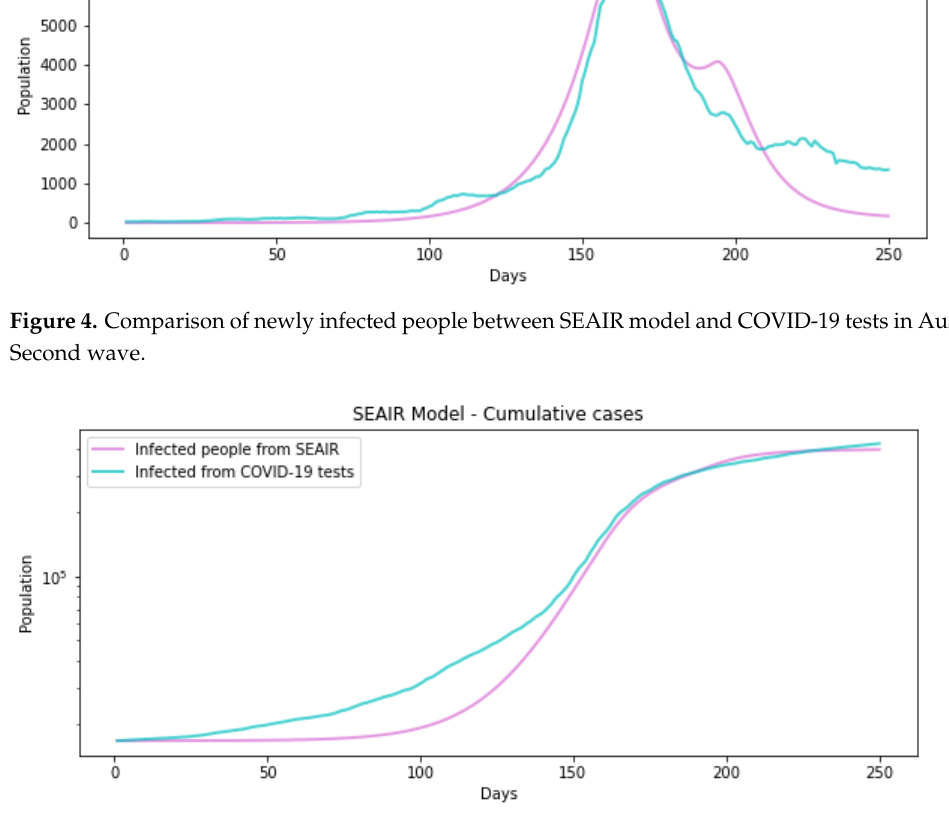
Figure 5. Comparison of cumulative infected people between SEAIR model and COVID-19 tests in Austria. Second wave. Table 7. Vaccines corresponding to the most vaccinated subgroups of the best vaccination plan obtained from SEAIRV model. Lower Vienna Styria Tyrol Salzburg Austria